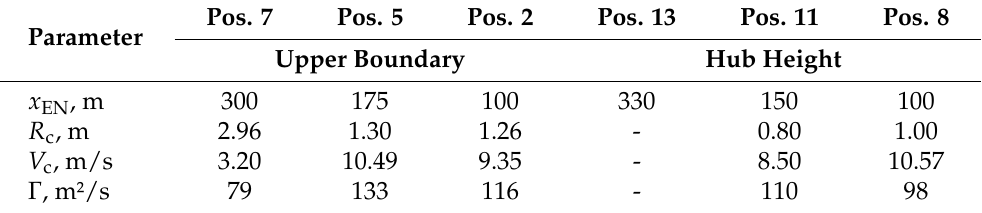
Figure 7. Instantaneous streamwise velocity and λ 2 -isosurfaces in the WT wake flow field of C2 at V W = 25.0m/s. Note that the WT geometry is plotted for more clarity, but was not resolved in the CFD simulation of C2. (OS-1). Table 3. Selected blade tip vortices for the piloted simulation of vortex encounters with properties identified from the WT wake flow field in